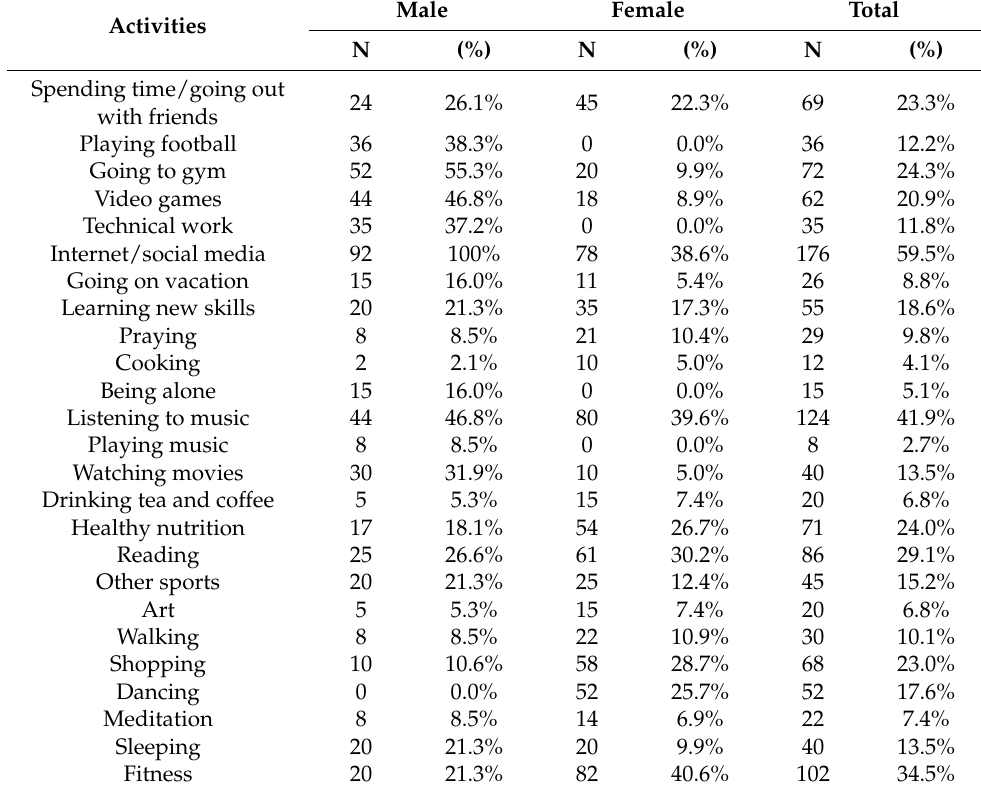
Table 4. Self-care activities suitable for their age and gender (question number